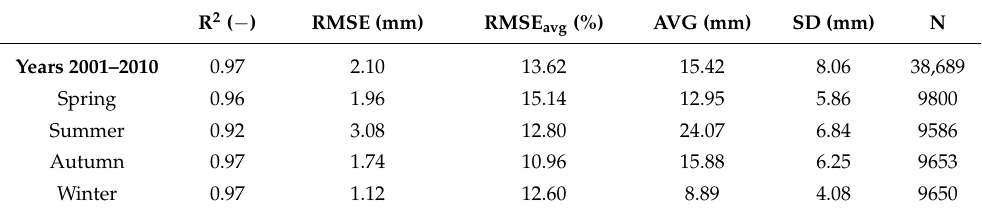
Table 3. Pearson correlation coefficients (R 2 ) and root mean square error in mm (RMSE) and % of PW average value (RMSE avg ) between PW data from WRF model and soundings. AVG—values of averages; SD—standard deviation of PW from soundings; N—number of